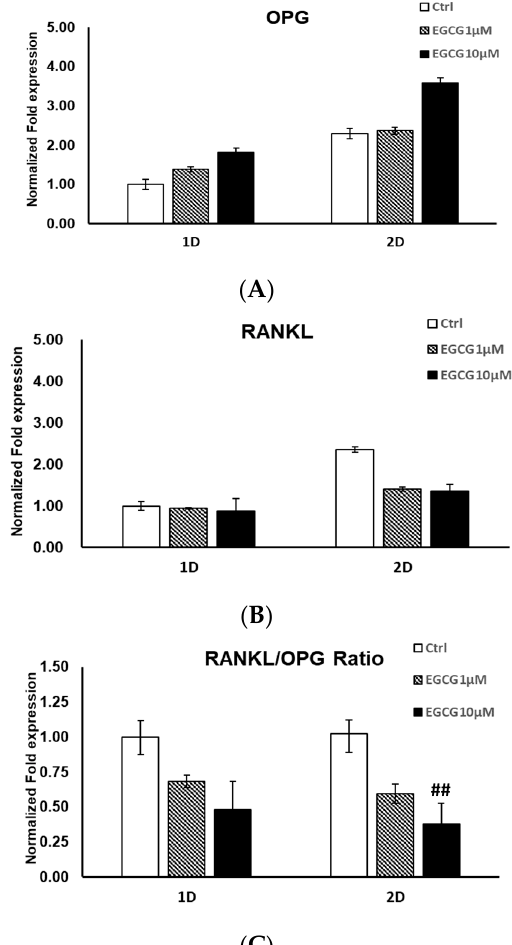
Figure 2. The mRNA expression of osteoprotegrin (OPG) and receptor activator of nuclear factor-kB ligand (RANKL) genes. ( A ) The mRNA expression of OPG increased after EGCG treatment for 24 and 48 h at concentrations of both 1 and 10 µmol/L. ( B ) The mRNA expression of RANKL decreased after EGCG treatment for 24 and 48 h at concentrations of both 1 and 10 µmol/L. However, the difference did not reach statistical significance. ( C ) The ratio of RANKL/OPG decrease at 10 µmol/L after treatment for 24 ( p = 0.06) and 48 h ( p = 0.005). ##: p < 0.01, compared with day 2 control.